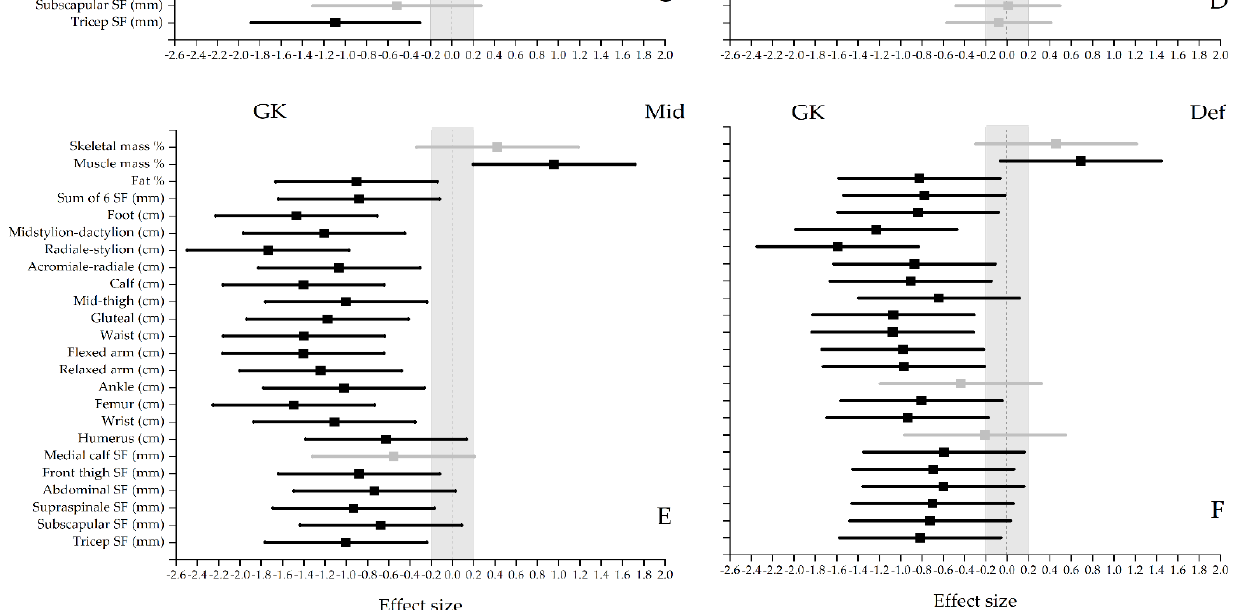
Figure 1. Effect size for position-specific anthropometric characteristics (95%CI). Differences between: Midfielders vs Forwards ( A ); Defenders vs Forwards ( B ); Goalkeepers vs Forwards ( C ); Defenders vs Midfielders ( D ); Goalkeepers vs Midfielders ( E ); Goalkeepers vs Defenders ( F ). Points estimates are colour-coded as “unclear” (grey) and “meaningful” (black). Negative effect sizeds indicate a higher measurement for the position named first in the description.